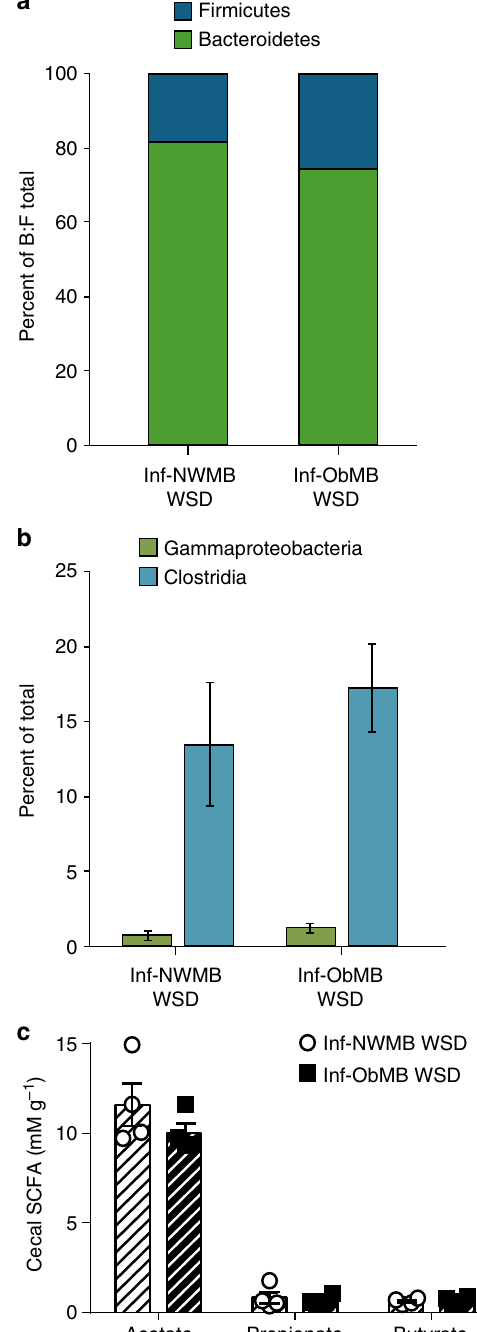
Fig. 7 Inf-NWMB and Inf-ObMB gut microbiota are not different after 6 weeks on WSD. Cecal microbiota Bacteroidetes to Firmicutes (B:F) ratio ( a ), shown as percent of total of these two phyla, and Gammaproteobacteria and Clostridia relative abundances ( b ). c Acetate, propionate, and butyrate SCFA concentrations in the cecum in colonized mice fed a WSD; data are presented as mean ± SEM. a – c n = 4 for both